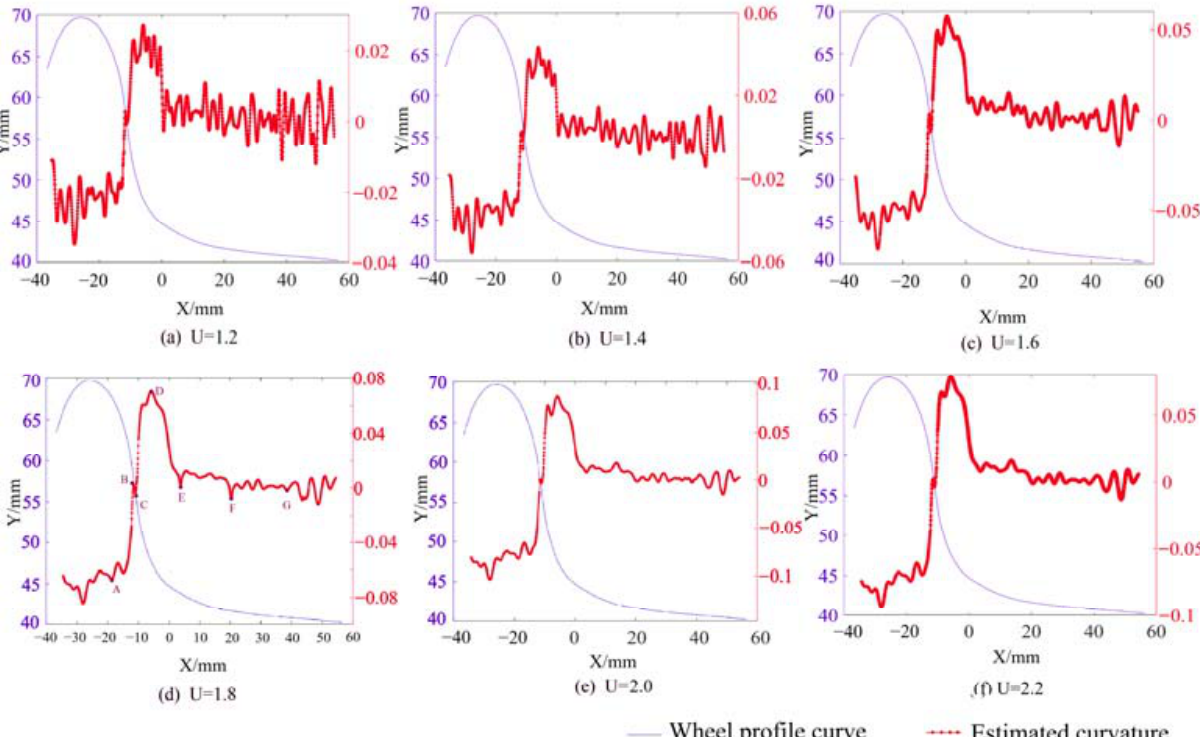
Figure 8. Curvature estimation based on the U-chord method.